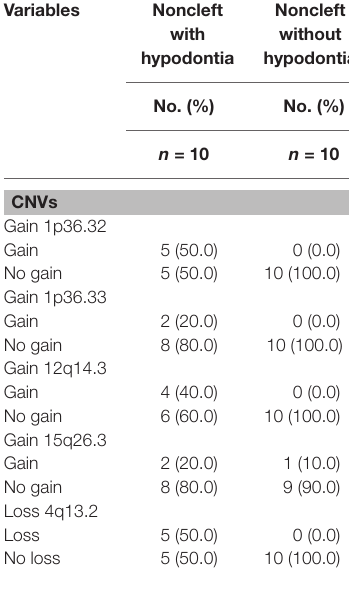
TABLE 2 | Association between noncleft with or without hypodontia with copy number variations (CNVs). Variables Noncleft